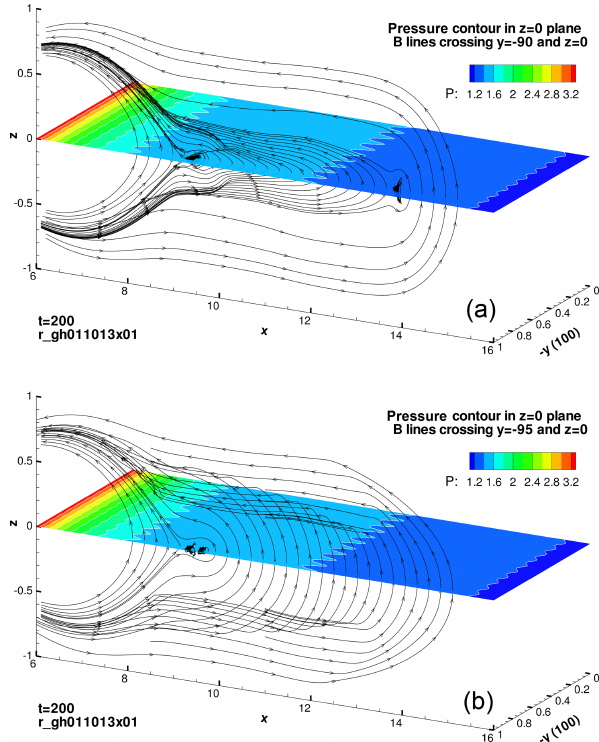
Figure 3. Magnetic field lines crossing lines y = − 90, z = 0 (a) and y = − 95, z = 0 (b) , and pressure contours in the z = 0 plane at t = 200. The unit of all coordinate axes is Earth radius R E . The time unit is Alfvénic time τ A